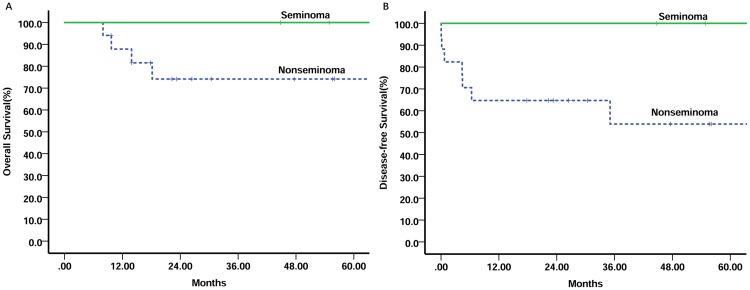
Kaplan-Meier overall survival (A p = 0.032) and disease-free survival (B p = 0.045) stratified by histology.